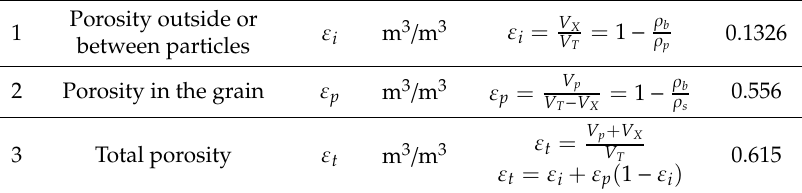
Table 1. Results of calculation porosity of a single fixed